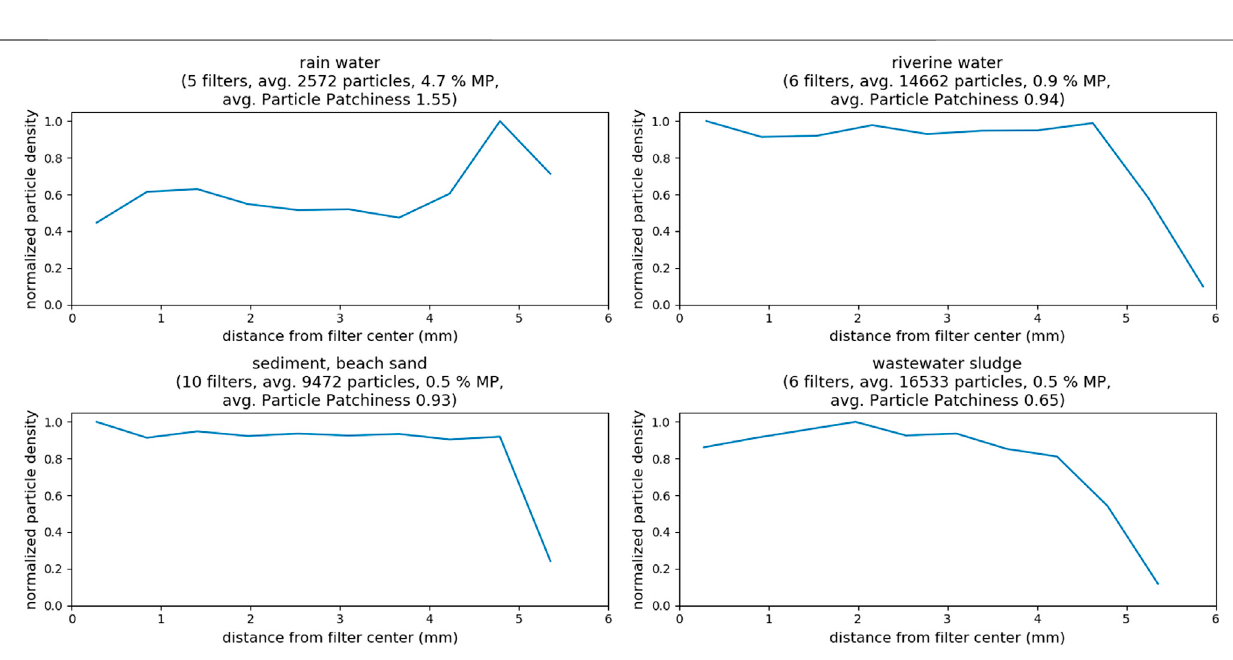
Frontiers in Environmental Science |